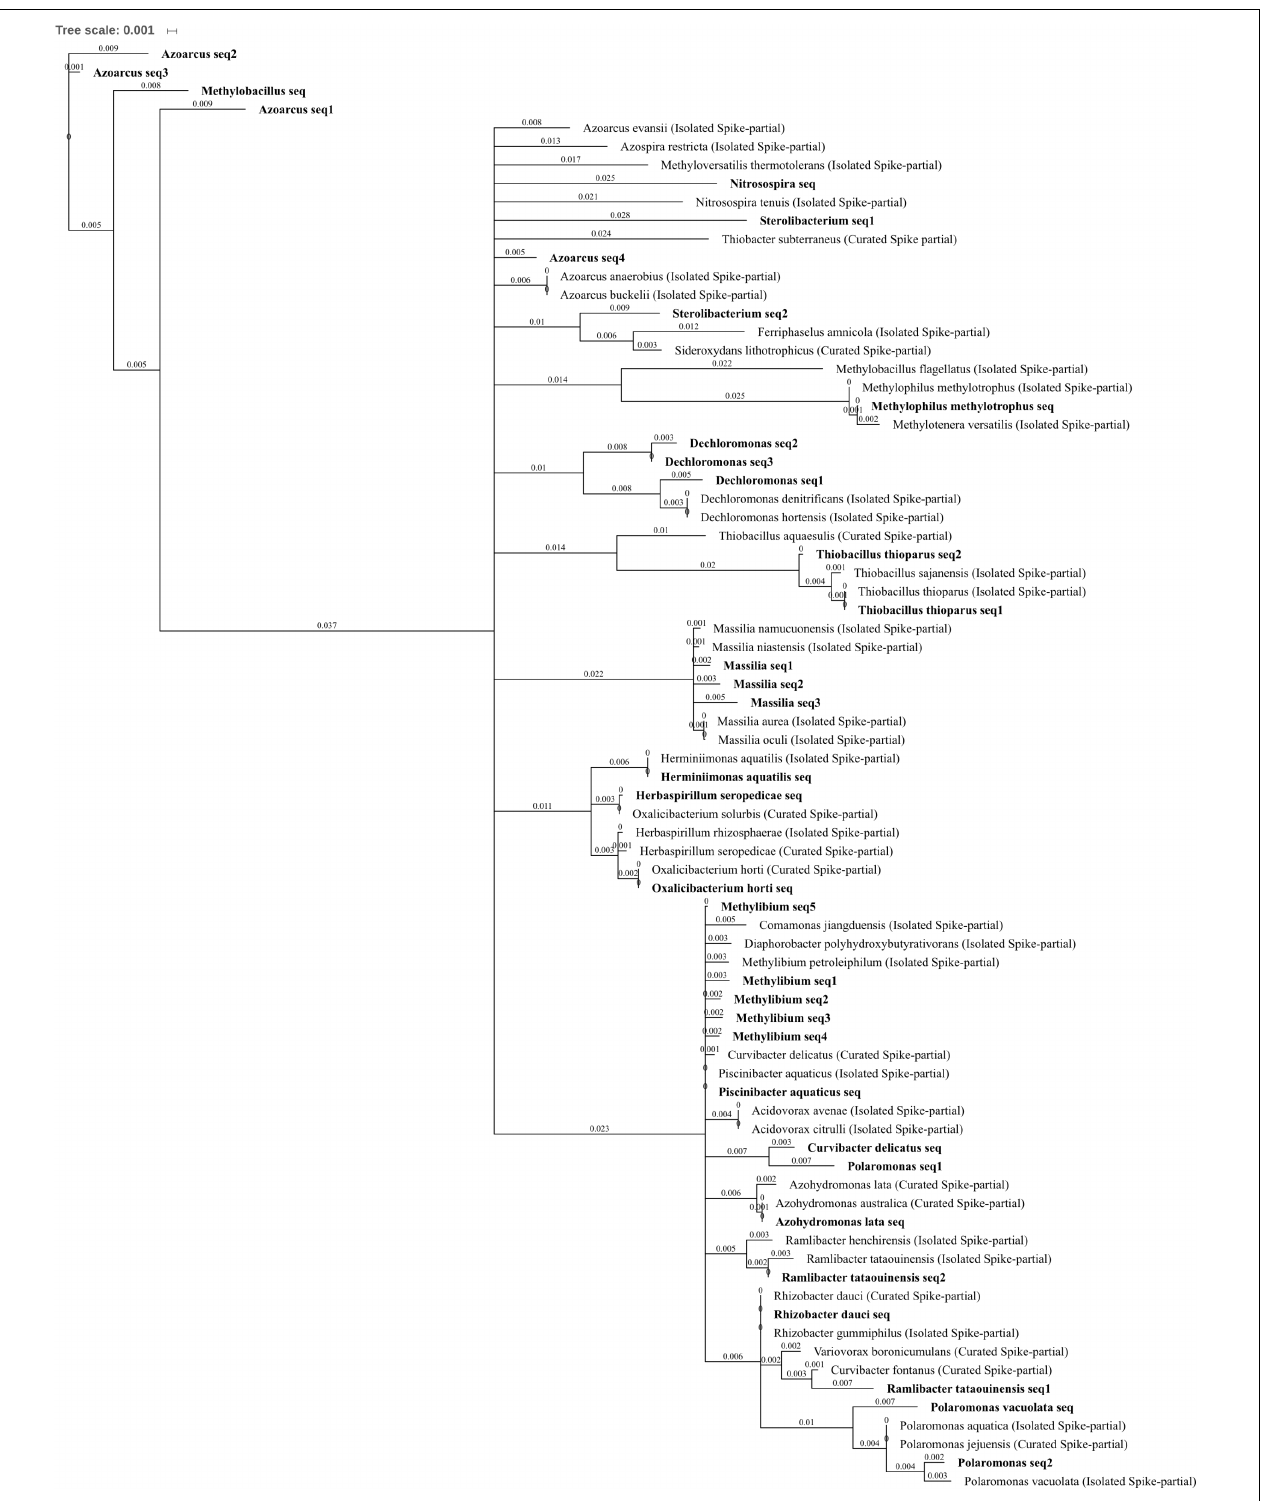
FIGURE 7 | Betaproteobacteria phylogenetic tree. Jukes–Cantor model with neighbor-joining and > 50% support threshold (1,000 replications). Sub-OTUs (distinct amplicons) are highlighted in bold with spike (into the tree) sequences included as the most similar hits from the NCBI bacteria and archaea 16S rRNA gene database. All accession numbers and sequences (sub-OTUs and tree spikes) are provided in Supplementary File 2 . The value “0.001” on the scale bar represents 1 substitution in 1,000 bp.